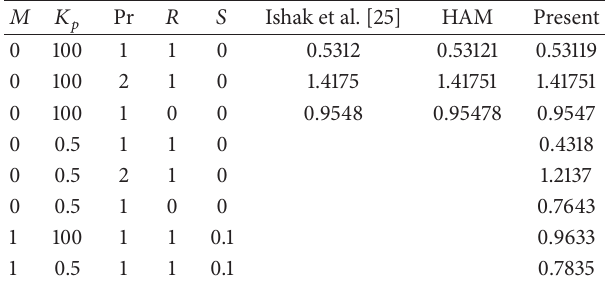
Table 2: Values of Nusselt number −𝜃 󸀠 (0) .